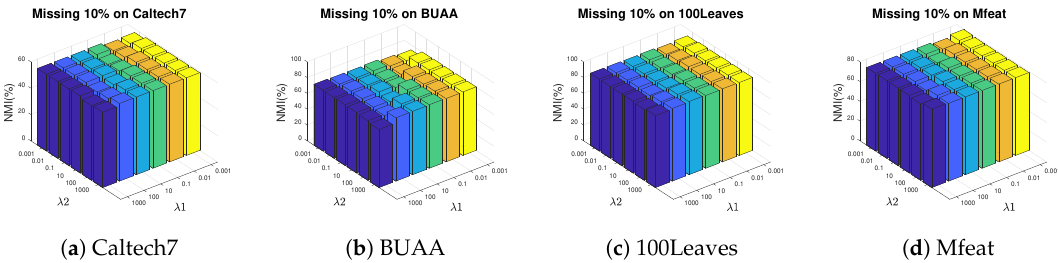
Figure 4. Parameter study on four incomplete datasets. Pictures depict the diversification of NMI under different parameter combinations in the condition of missing 10% instances.